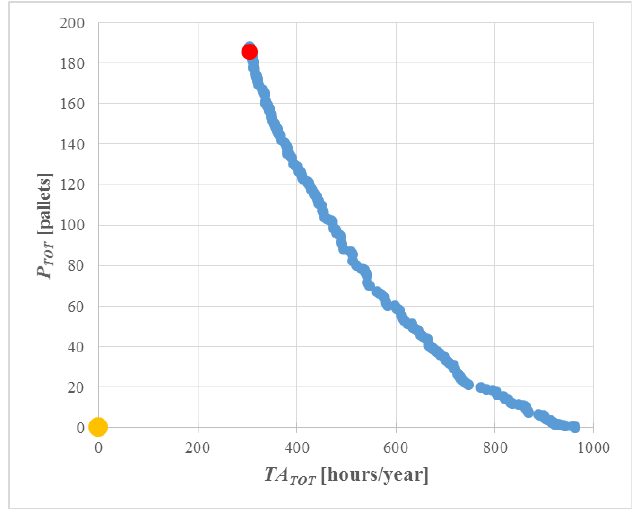
Figure 9. Case study bi-objective optimum point (in red) within Pareto frontier (in blue) compared to Utopia point (in yellow).